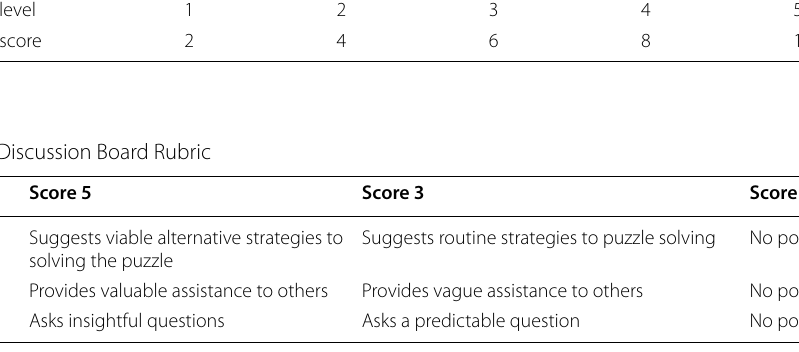
Table 2 Scoring chart for the challenge levels Challenge level